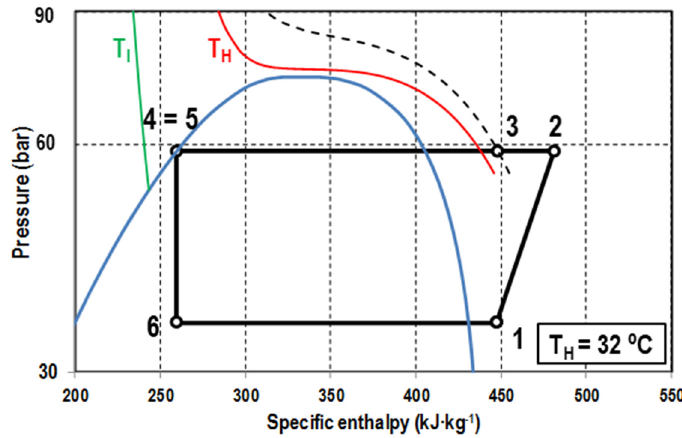
Figure 4. Pressure-enthalpy diagram of the low temperature cycle (CO 2 ) of the Figure 4. Pressure ‐ enthalpy diagram of the low temperature cycle (CO 2 ) of the cascade.